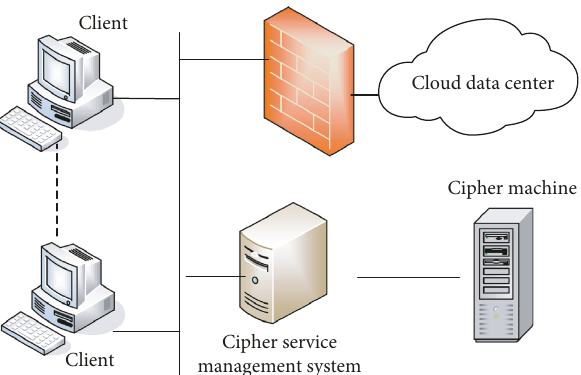
Figure 10: Multiuser cryptographic service.